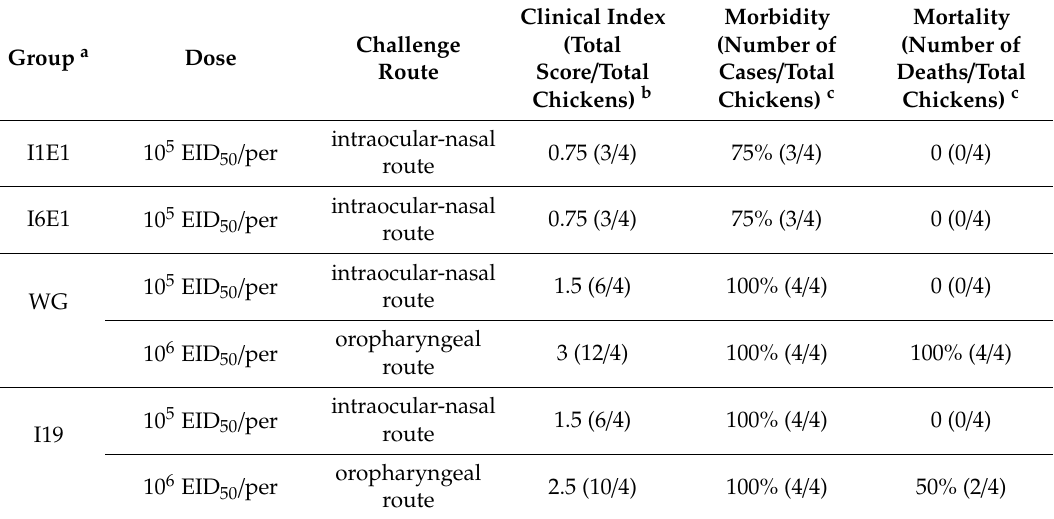
Table 2. The clinical index, morbidity, and mortality of I1E1, I6E1, WG, and I19.